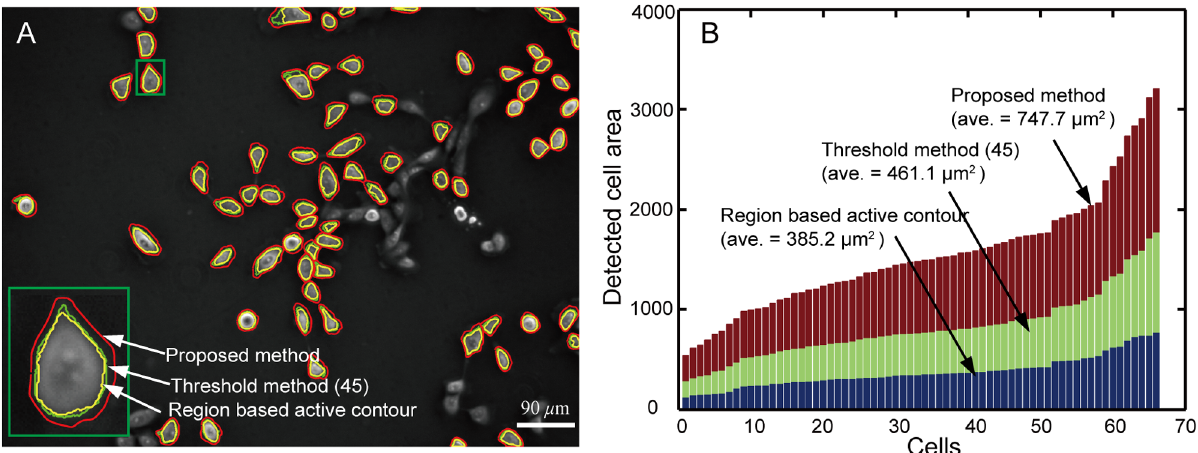
Fig 10. Comparison of boundary detection obtained with different methods for isolated cells. (A) The boundaries detected with the thresholding method, region based active contour method, and the contour expansion method for all isolated cells in the field of view. (B) Comparison of the areas enclosed by the contours detected with different methods. The proposed method detects much larger areas than the other two